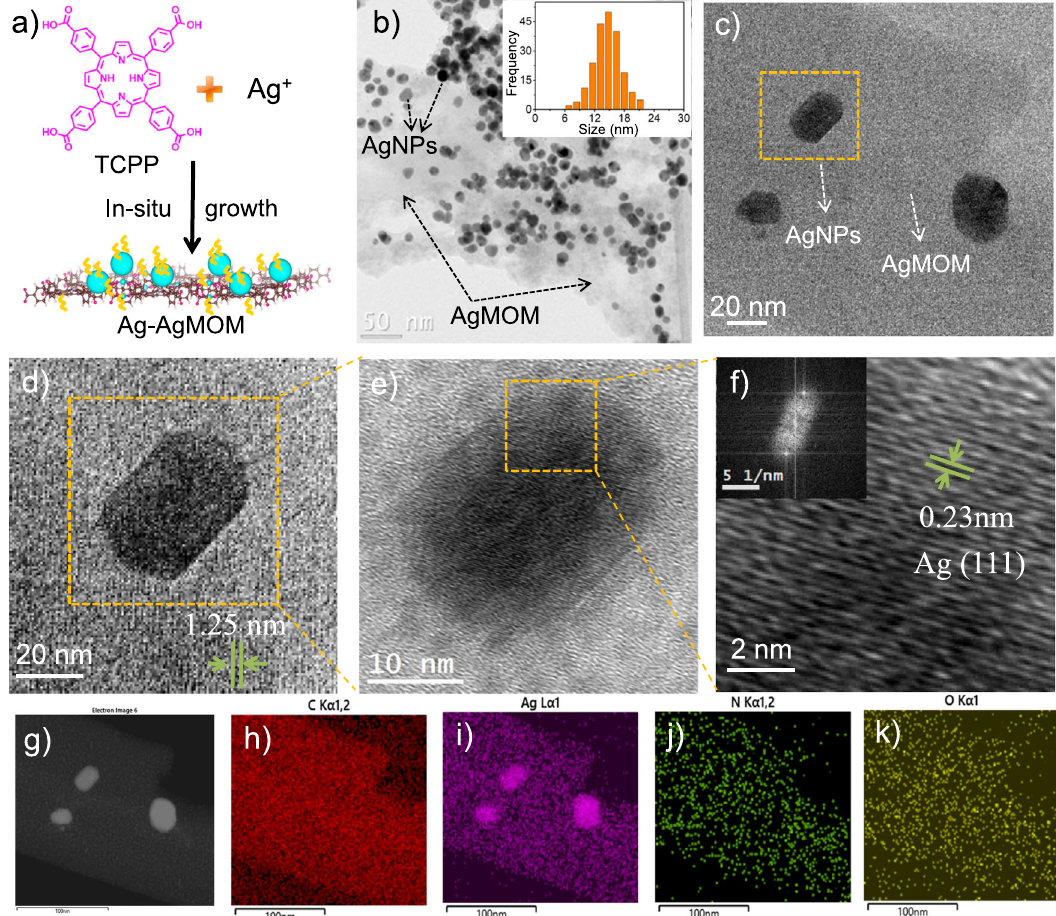
Fig.1|MorphologycharacterizationsofAg – AgMOM.a Schematicdiagramofthe one-stepsynthesisofAg – AgMOMusingin-situsolvothermalmethod. b Typicallow magni fi ed TEM imageof Ag – AgMOMwithreactiontime28h.Insetisthestatistical size distribution of Ag nanoparticles (AgNPs). c , d Enlarged TEM images of Ag – AgMOM; the lattice of AgMOM was observed. e , f HR-TEM images and crystal